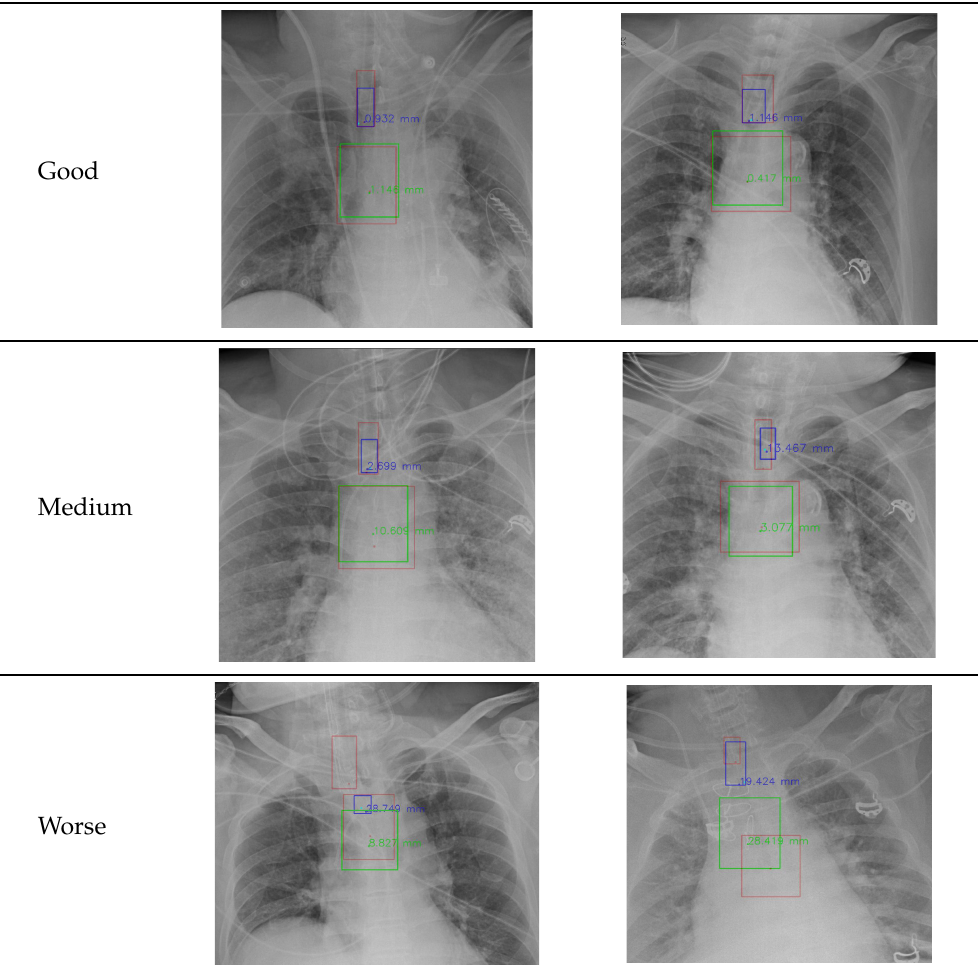
Table 23. The visualization